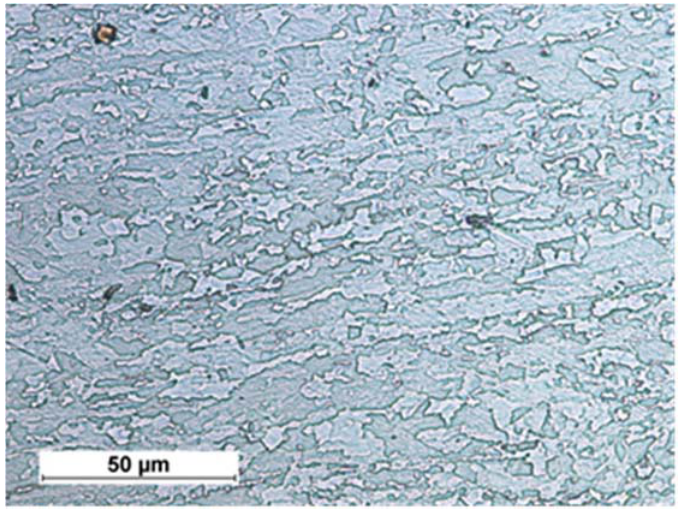
Figure 1. Structure of bainitic ‐ ferritic steel S700MC with visible effects of plastic deformation.